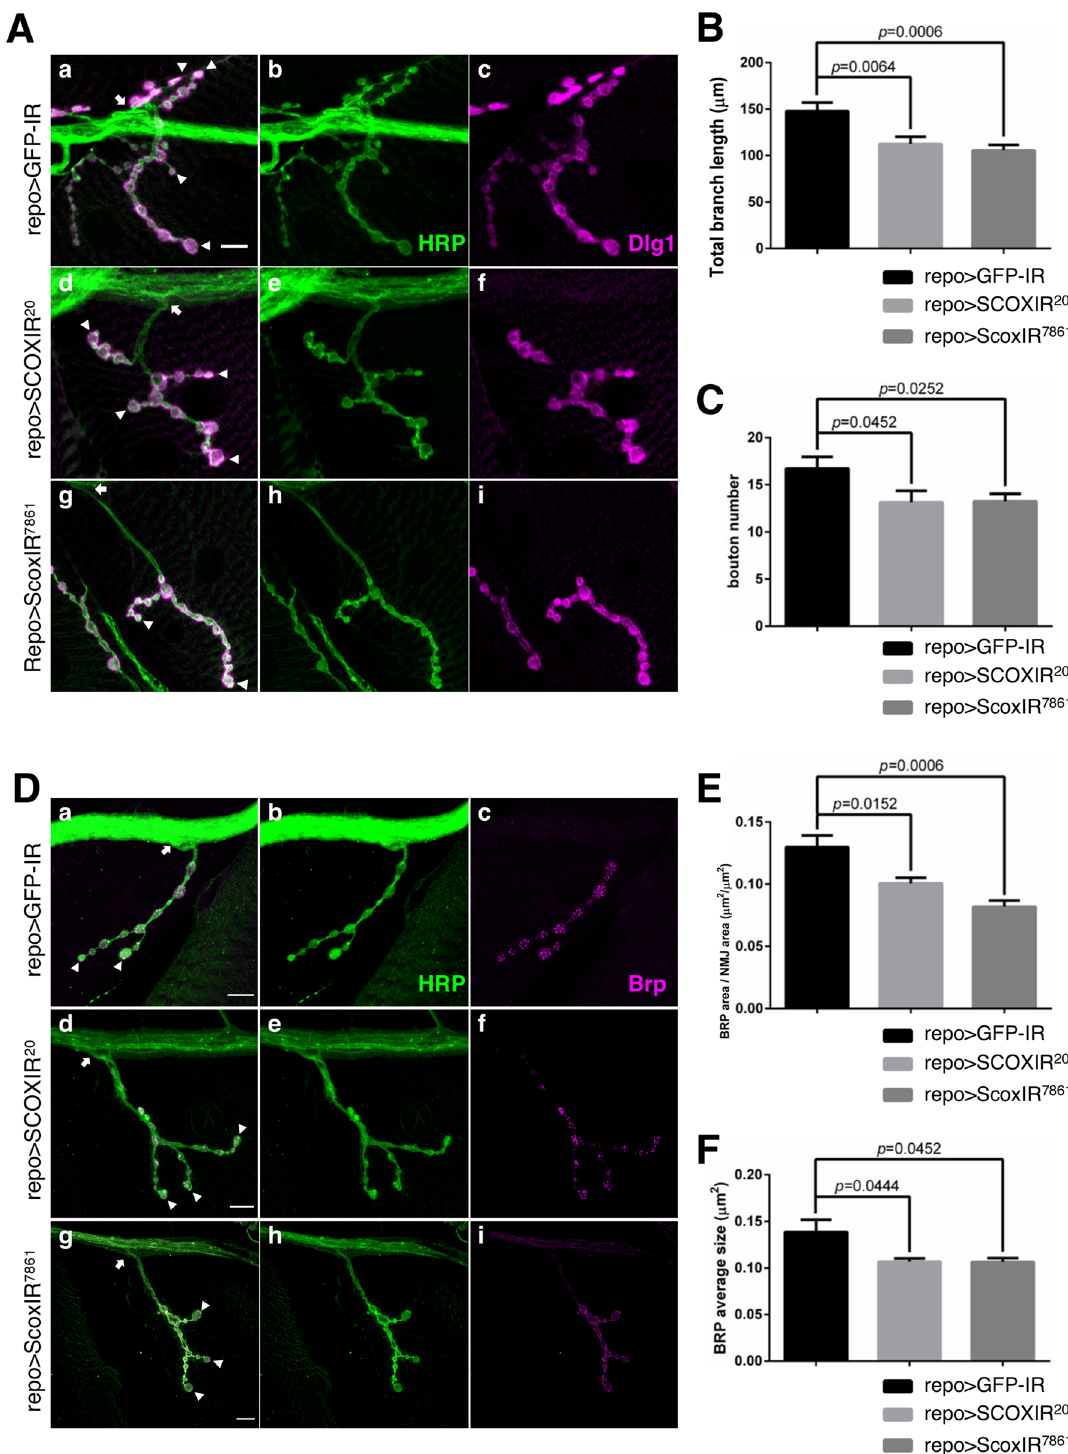
Figure 4. Scox plays an important role in the morphogenesis and function of synapses in the NMJ of third instar larvae. The synapse in the NMJ on the fourth muscle was inspected. ( A ) The pre and post synapses were marked with neuronal membrane marker anti-HRP (green) and postsynaptic marker anti-Dlg1 (magenta) antibodies, respectively. The total length of synapses between the arrow and arrowhead was measured as the total branch length. The scale bar indicates 10 µm. ( B , C ) Quantification of synapse branch length ( B ) and the number of boutons ( C ). GFPIR; n = 17, SCOXIR 20 ; n = 19, ScoxIR 7861 ; n = 21. ( D ) The active zone in the NMJ of the fourth muscle was marked by anti-Brp antibody (magenta). The number and size on Brp signals between the arrow and arrowhead were analyzed. The scale bar indicates 10 µm. ( E , F ) Quantification of active zone density ( E ) and active zone size ( F ). GFPIR; n = 9, SCOXIR 20 ; n = 7, ScoxIR 7861 ; n = 8. repo > GFP-IR ( UAS-GFP-IR/ + ; r epo-GAL4/ +), repo > SCOXIR 20 ( UAS-SCOXIR 20 / + ; repo- GAL4/ +), repo > ScoxIR 7861 ( repo-GAL4/UAS-ScoxIR 7861